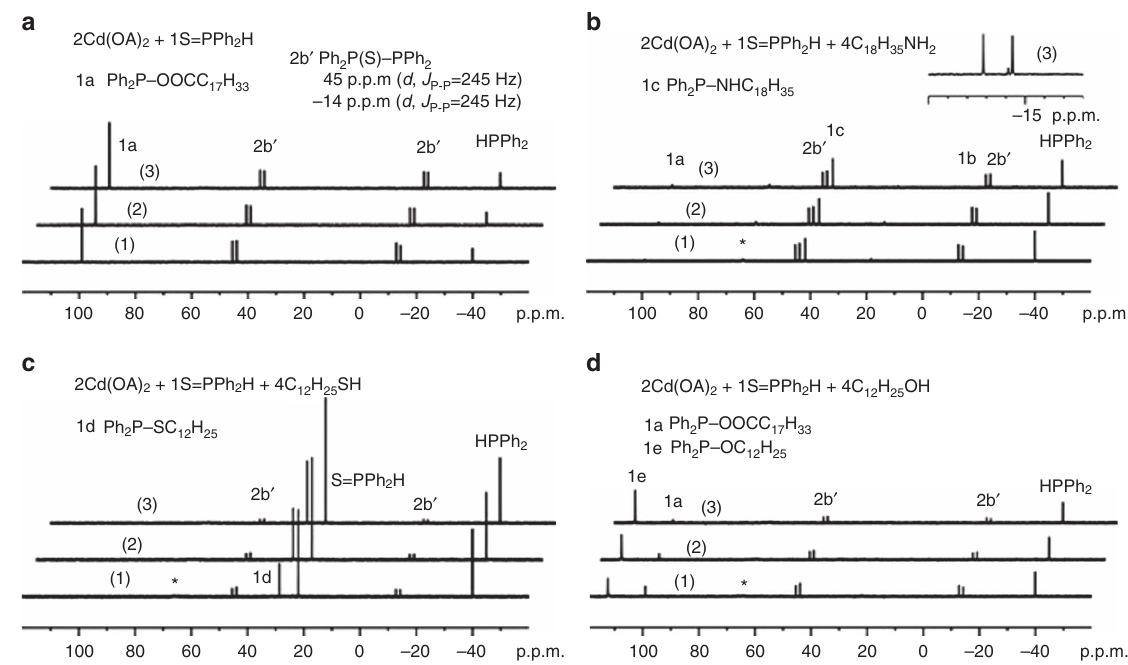
Figure 2 | 31 P NMR spectra of CdS reaction mixtures with S precursor. ( a ) 2Cd(OOCC 17 H 33 ) 2 þ S ¼ PPh 2 H. ( b ) 2Cd(OOCC 17 H 33 ) 2 þ S ¼ PPh 2 H